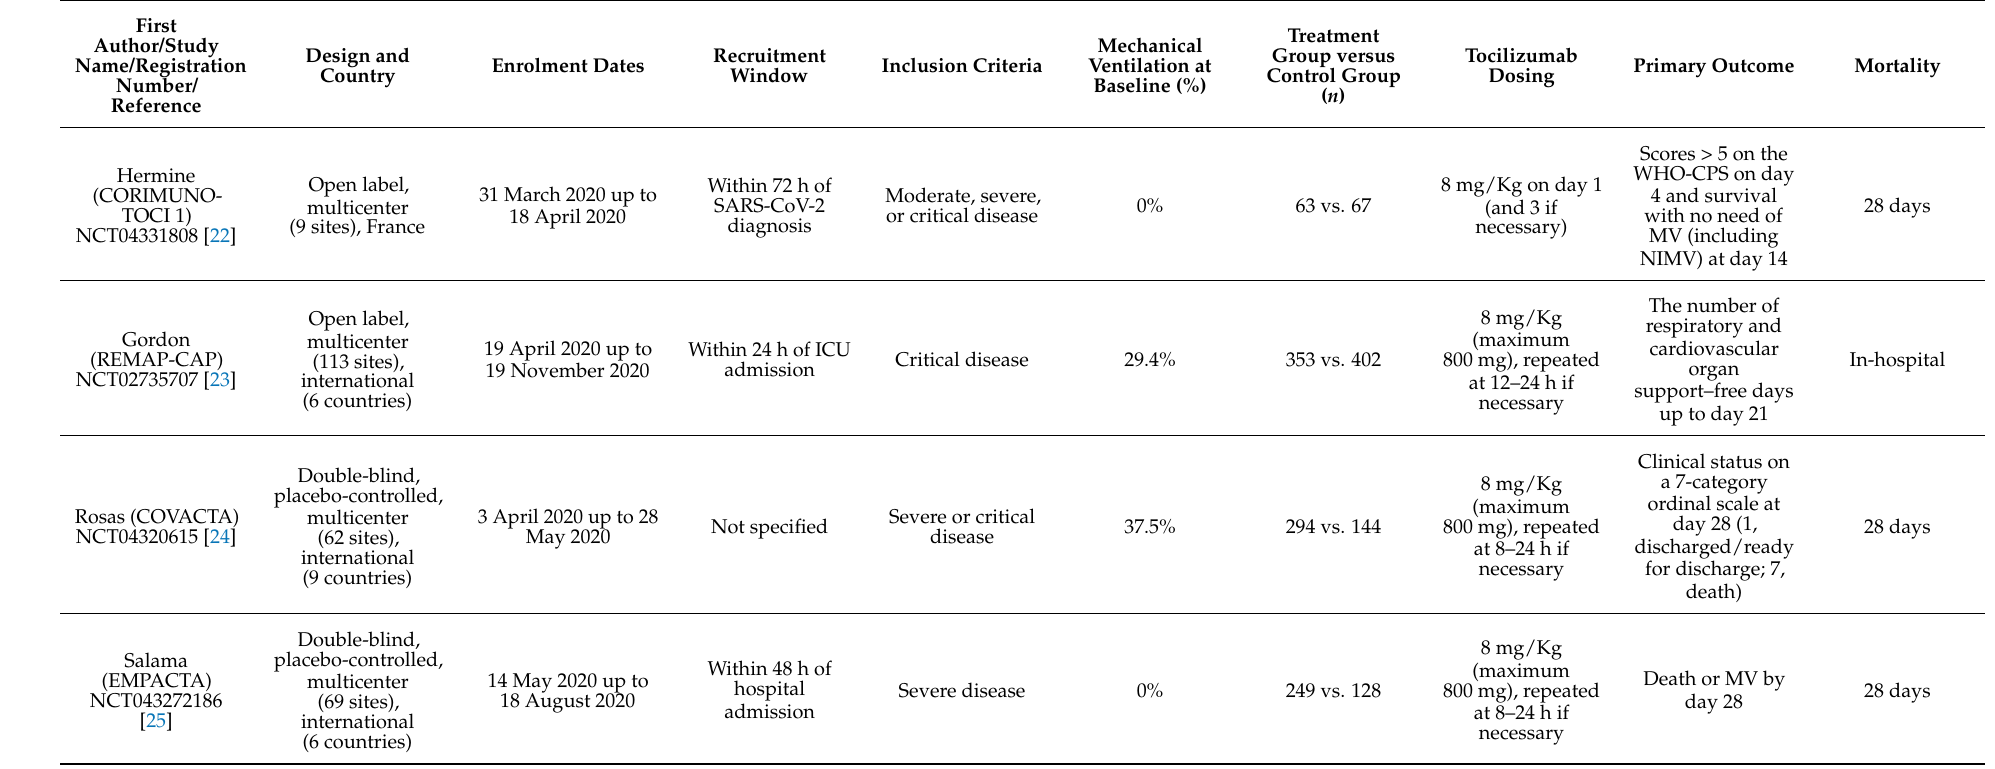
Table 1. Characteristics of included studies (only randomized controlled